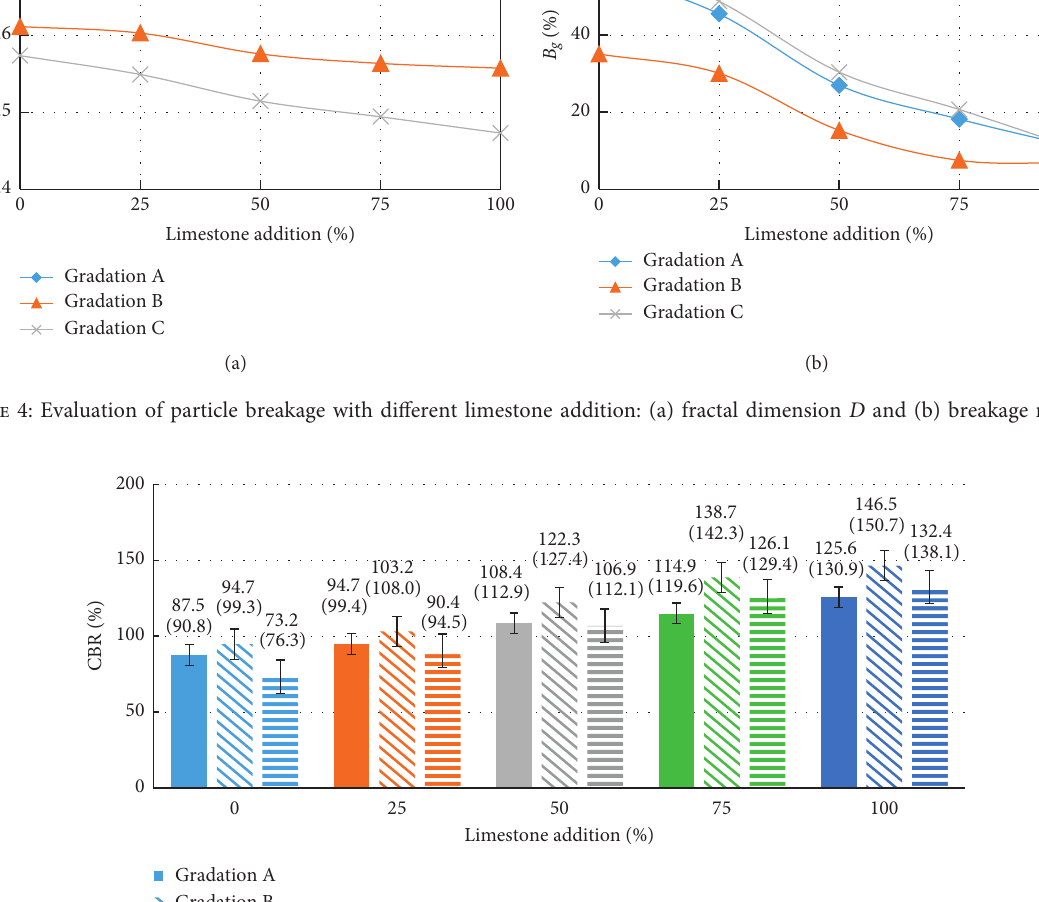
Figure 5: Results of California bearing ratio test.